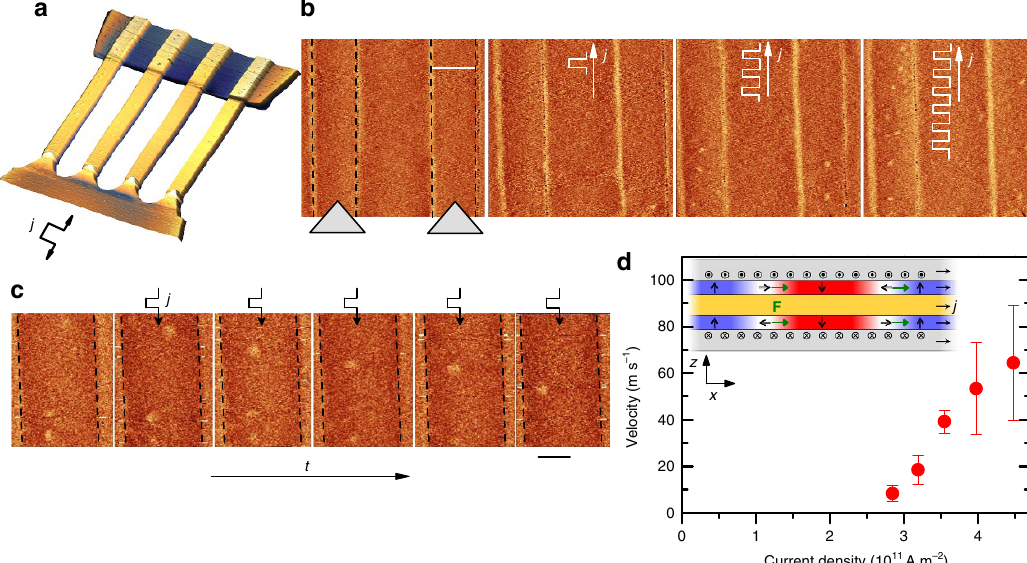
Figure 2 | Skyrmion generation and dynamics. ( a ) AFM image of the asymmetric device with the skyrmion injection tips. ( b ) Skyrmion writing by at B z ¼ (cid:2) 6mT by 7ns long, j ¼ 2.8 (cid:4) 10 11 Am (cid:2) 2 pulses starting from a fully saturated state, with one injected skyrmion after application of first pulse, and several skyrmion after a train of pulses. The dashed lines and triangles correspond to the wire edges and electric contacts respectively. Scale bar, 1 m m. ( c ) Series of images showing skyrmion shift along the track between 3ns, j ¼ 3.9 (cid:4) 10 11 Am (cid:2) 2 electric pulses. Scale bar, 500nm. ( d ) Measured velocity of skyrmions as a function of current densities at B z ’ (cid:2) 6mT. Error bars correspond to the s.d. The inset shows a sketch of the skyrmion cross section with the spin accumulation due to the electrical current j. The resulting force F (green arrows) defined by equation (2) causes both skyrmions to move in the same direction (against the electron flow). AFM, atomic force microscopy.